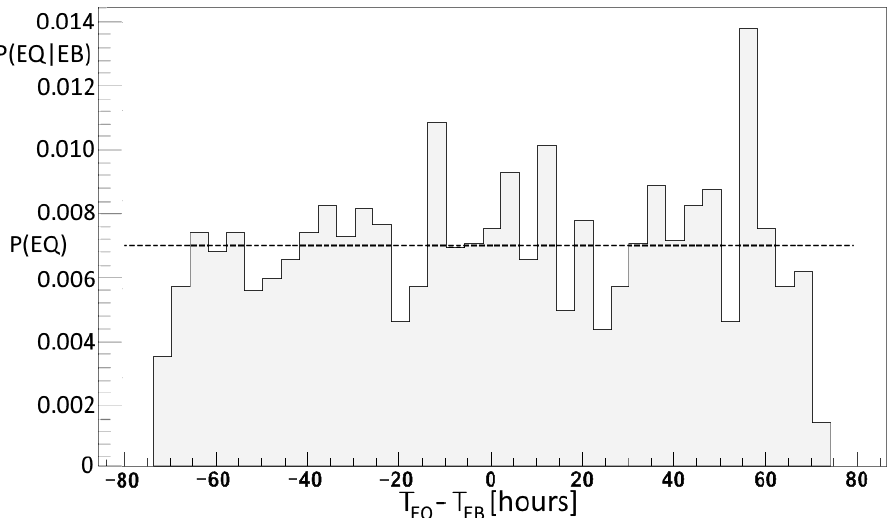
Figure 9. The conditional probability distribution P(EQ|EB) which corresponds to the correlation bin of 4 h in Figure 2, the average probability indicated by a horizontal dashed line coincides with the unconditional probability P(EQ).